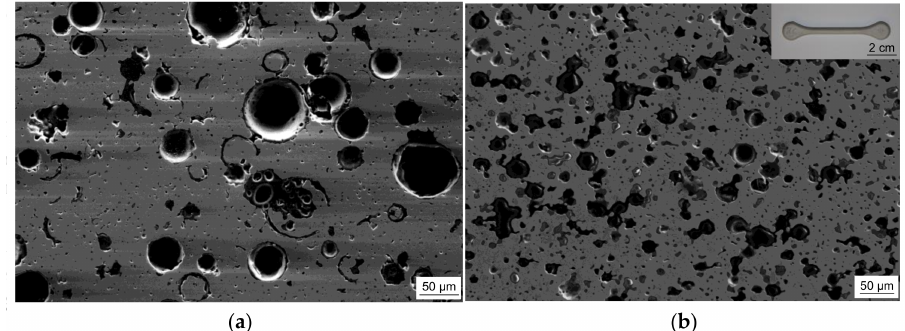
Figure 1. SEM images of two syntactic TRIP-steel matrix foams as-sintered: ( a ) with 40 vol % cenospheres (T4C); ( b ) containing 40 vol % glass microspheres (T4G); the overlay image in ( b ) illustrates the raw dog-bone